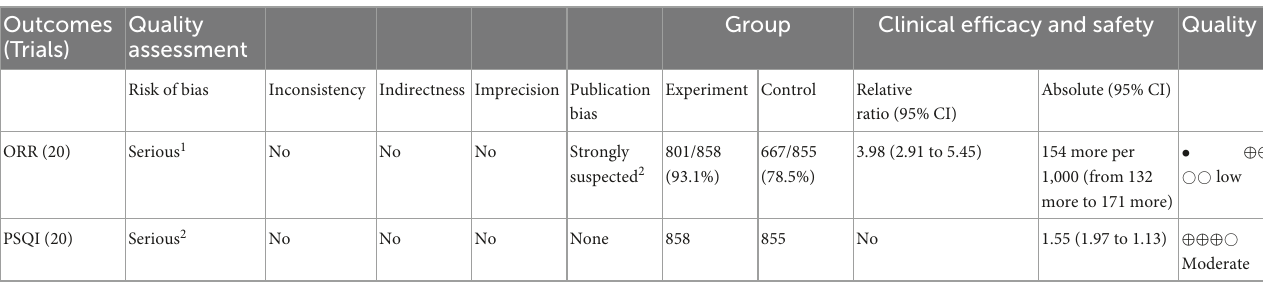
TABLE 2 GRADE evidence